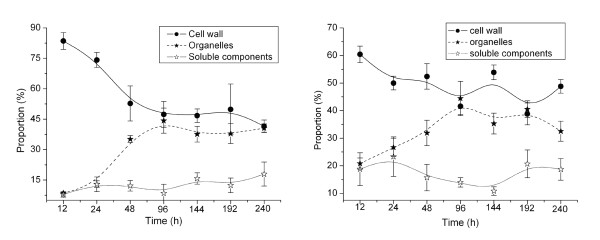
Proportions of phenanthrene (a) and pyrene (b) distributed in cell water soluble fraction, wall and organelle as a function of uptake time. The proportion of PAHs was calculated from the measurement of PAH in each fraction to the total amount in ryegrass root cells.